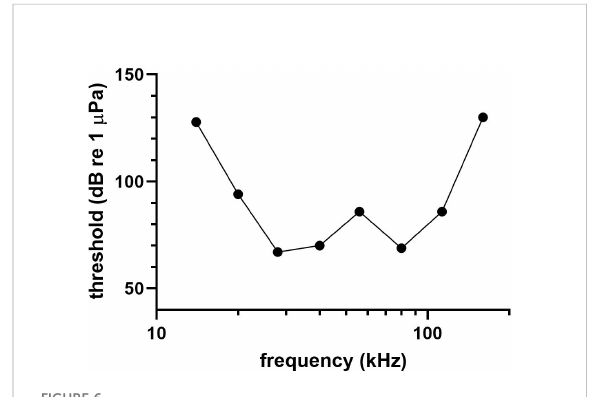
FIGURE 6 Audiogram of the Atlantic spotted